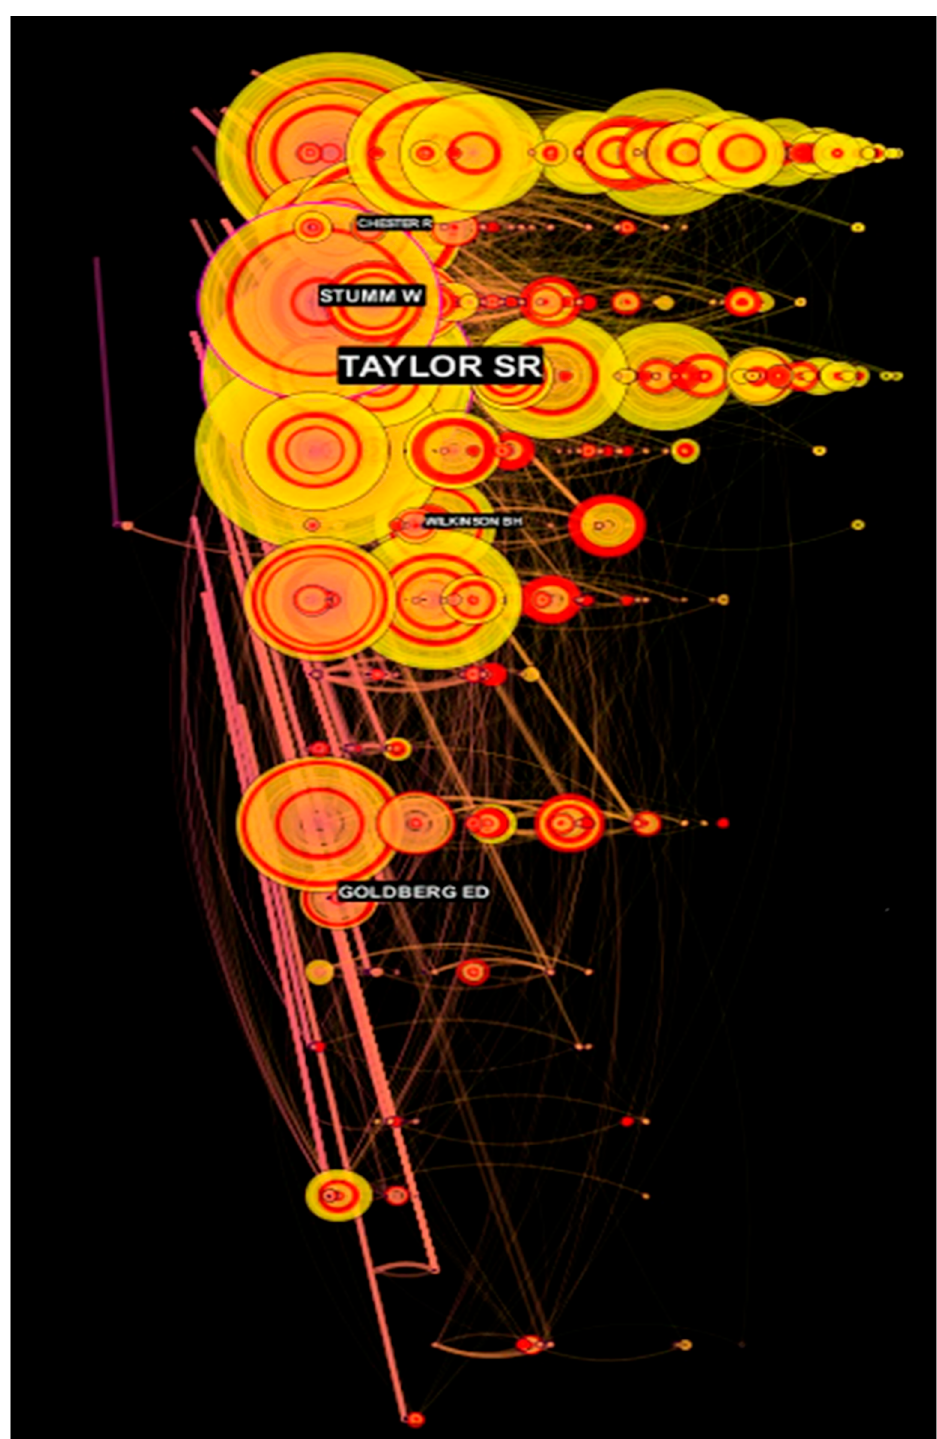
Figure 3. The most cited authors in studies related to the impacts of climate change on heavy metal contamination in coastal areas, based on the Web of Science Core Collection database (1979–2021). Additionally, the publications that referenced studies related to the impacts of cli- mate change on heavy metal contamination in coastal areas are shown in Figure 4. Audry et al. [28] studied Cd, Cu, Co Ni, U, Mo and V diagenesis in a macrotidal estuary, which appeared to be the most cited article in the related studies, with a centrality of 0.20. Ad- elson et al. [29] studied Mo in coastal sediments, which appeared to be the second most cited article in the related studies, with a centrality of 0.12. The study of the composition